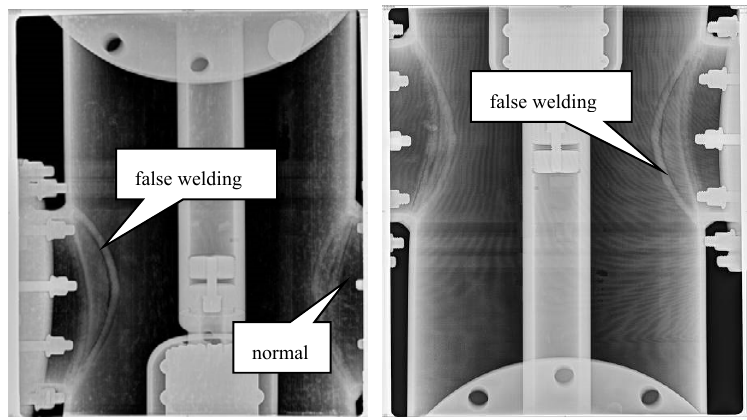
Figure 14. The normal and loosened metal screws.